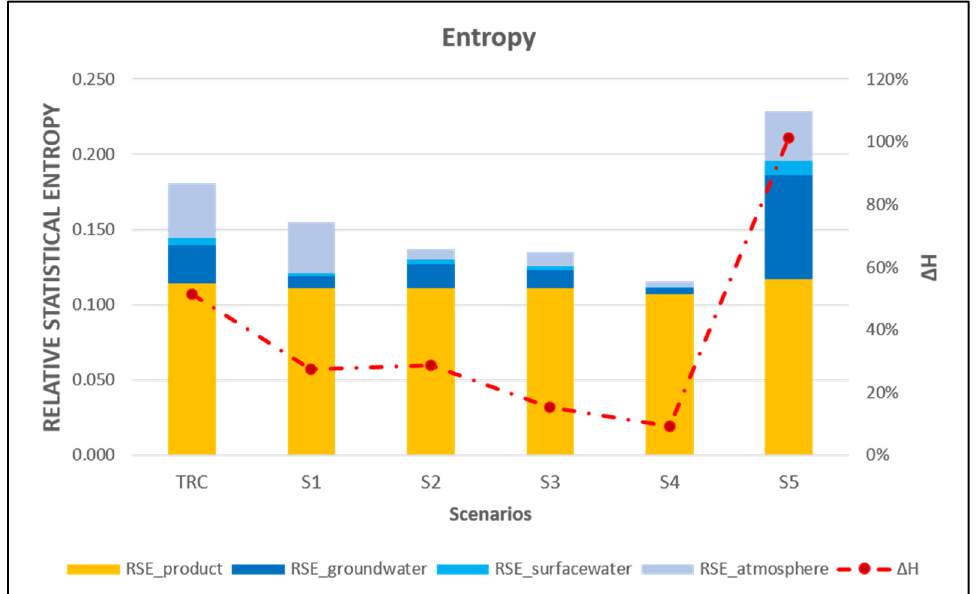
Figure 6. Simulated relative statistical entropy output contributions for the Tiber River Catchment system (RTC) with the relative efficiency values Δ H, expressed as a percentage, in different management scenarios compared to the actual TRC scenario.